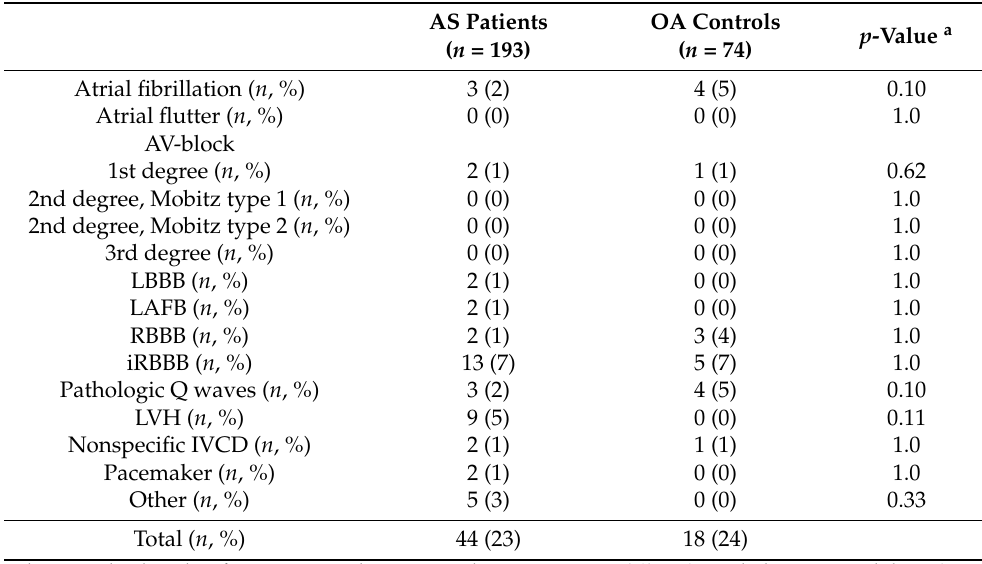
Table 3. Electrocardiographic